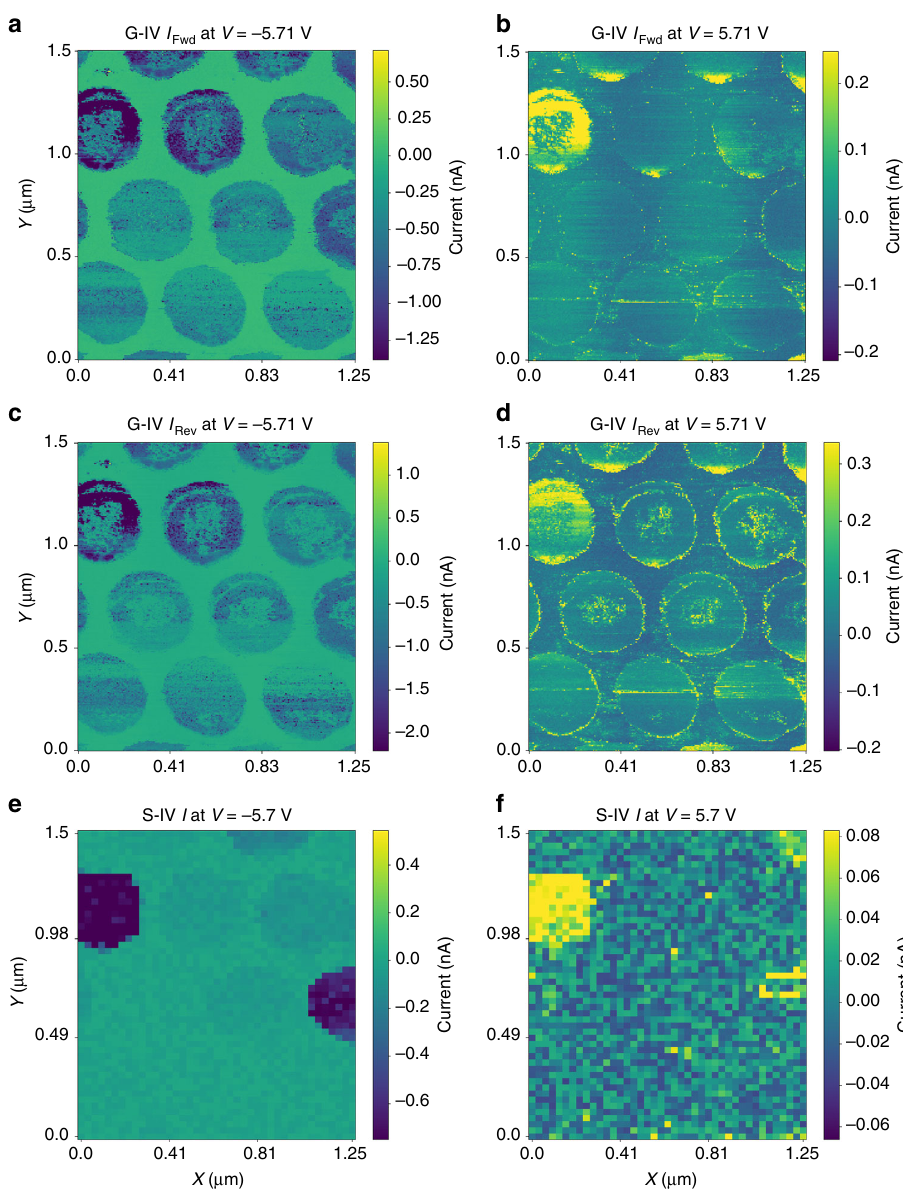
Fig. 4 Current maps for standard and G-IV methods. After reconstruction of the current at every pixel, it is possible to visualize the results of the G-IV acquisition in the same manner for the standard IV measurement. Shown in a – d are voltage slices (taken at both negative and positive extremes) for the forward ( a , b ) and reverse ( c , d ) voltage directions. The maps of current from the standard IV measurement, in the same region, are shown in e , f for e negative and f positive voltages. In general, there is a good agreement; however, exact correspondence is not expected, due to the detection of ferroelectric switching current in the G-IV method (absent in the standard IV